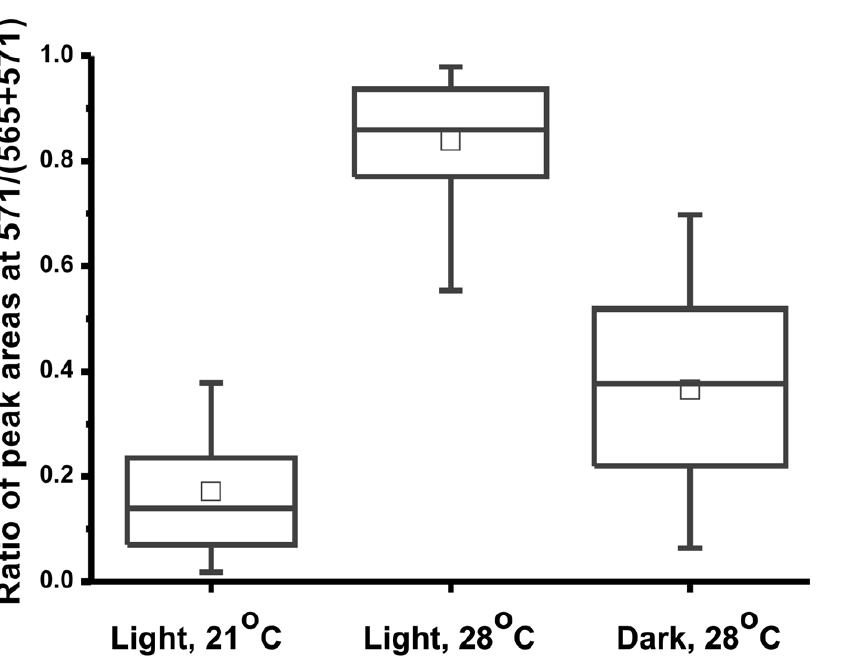
Figure 4. Influence of temperature (21 vs. 28 u C) and illumination (dark vs. light) on the labeling of glucose moiety in UDP-glucose molecules extracted from individual eggs. Female flies were incubated with 13 C 6 -glucose solution during 24 h. The default conditions were: white light on, , 4000 lux (in the study involving the change of temperature); temperature, 28 u C (in the study involving the change of illumination).